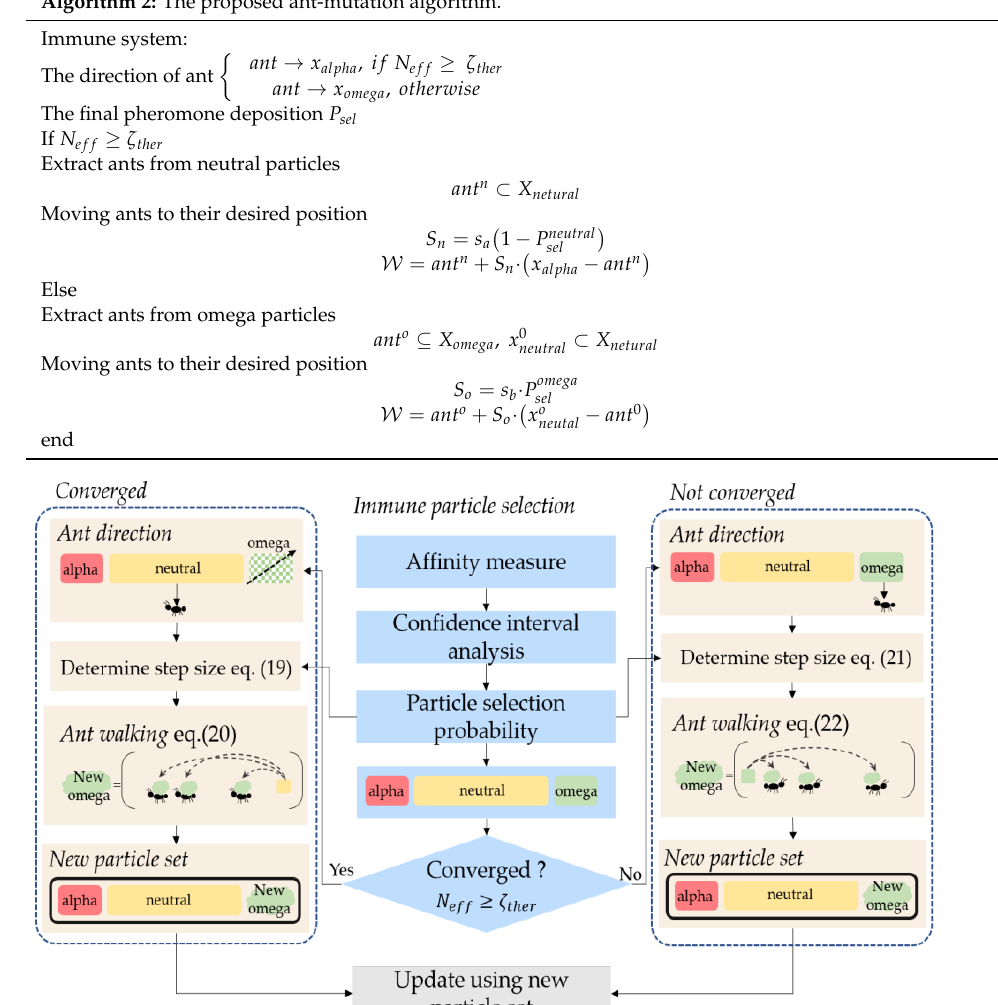
Algorithm 2: The proposed ant-mutation algorithm.